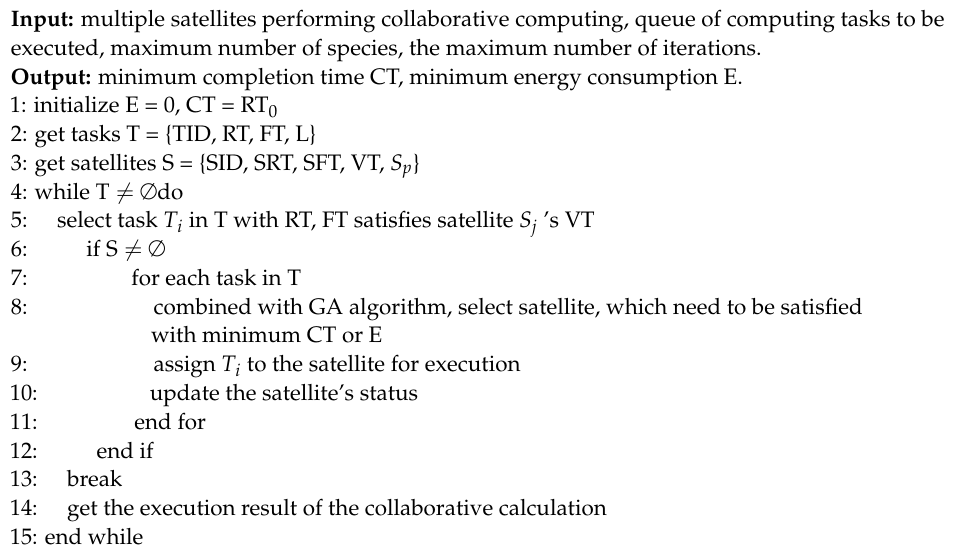
Algorithm 1. Distributed Collaborative Computing Framework with a Genetic Algorithm-based task scheduling